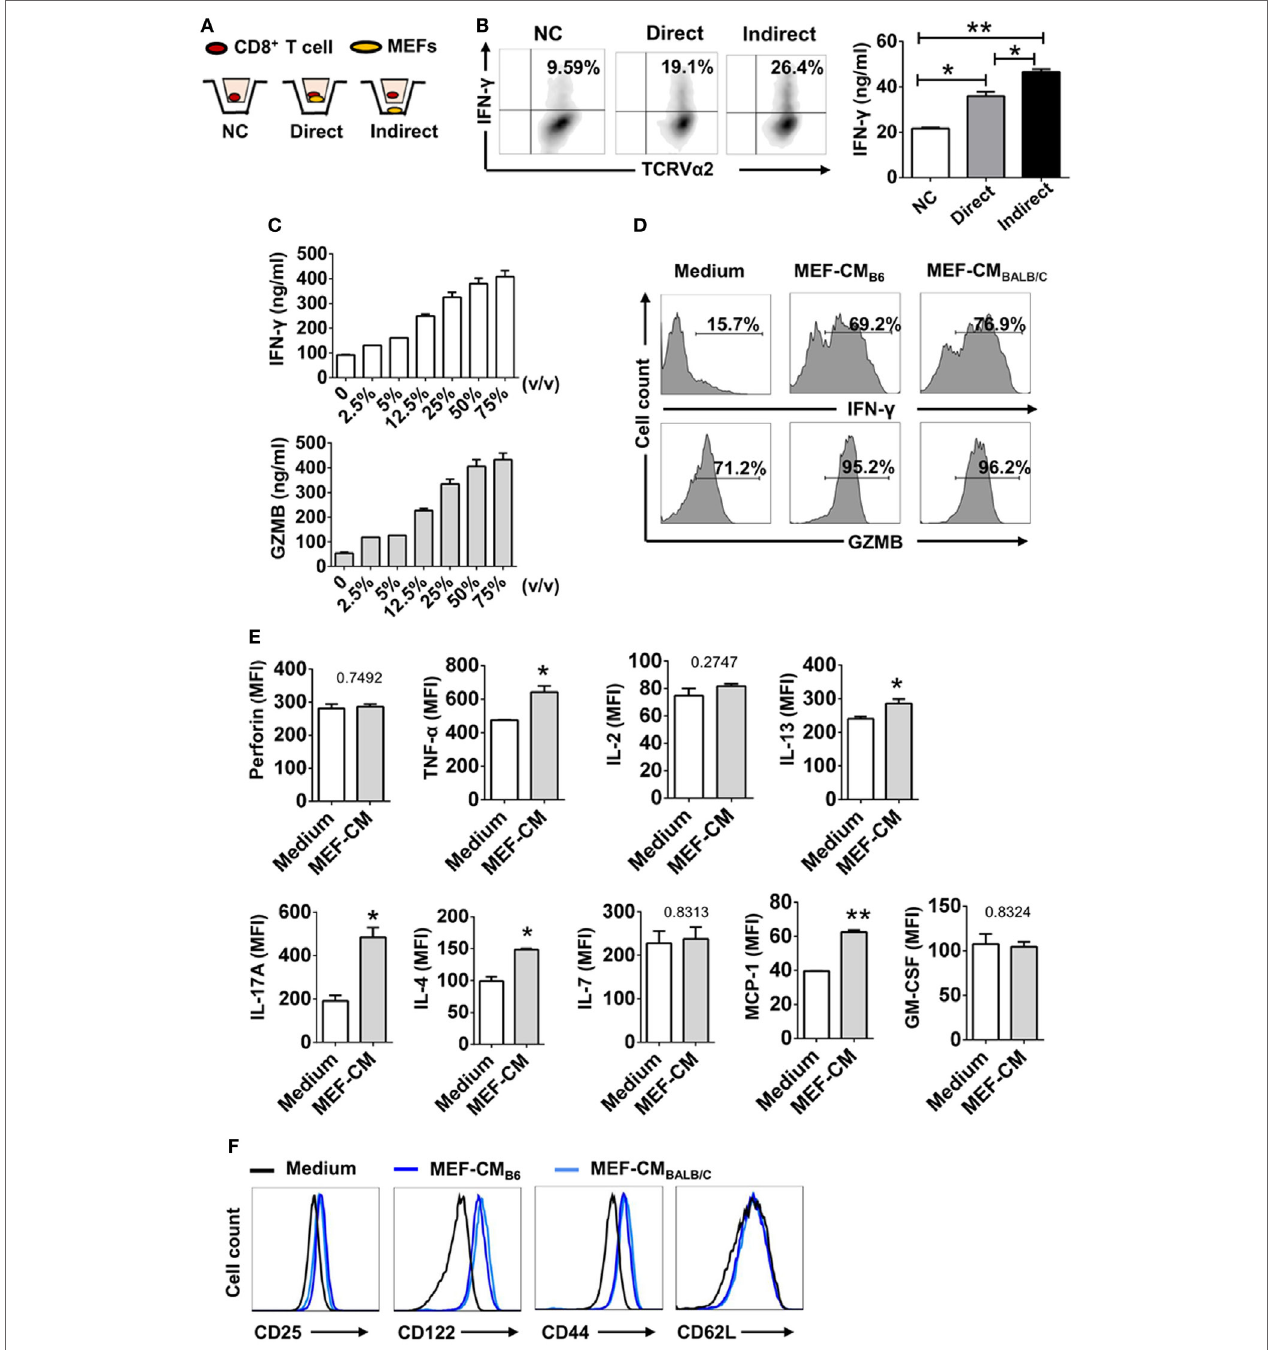
FigUre 2 | Mouse embryonic fibroblasts (MEFs) promote activation of CD8 + T cells through soluble factor(s). (a) Schematic diagram of trans-well co-culture system. (B) OT-1 CD8 + T cells (1 × 10 5 ) were incubated alone (No MEFs) or together with 2.5 × 10 5 B6 MEFs in the upper chamber (Direct), or CD8 + T cells in the upper chamber were incubated with 2.5 × 10 5 MEFs in the lower chamber (Indirect). After 3 days of TCR stimulation, interferon-gamma (IFN- γ ) production was evaluated by intracellular flow cytometry analysis. (c) OT-1 CD8 + T cells (1 × 10 5 ) were stimulated with different volumes of B6 mouse embryonic fibroblast- conditioned medium (MEF-CM) for 3 days. IFN- γ and granzyme B (GZMB) levels were quantified by ELISA. (D) OT-1 CD8 + T cells were stimulated in the presence (50%, v/v) or absence of B6 MEF-CM or BALB/c MEF-CM. 2 days later, the level of IFN- γ and GZMB was determined by flow cytometry analysis. Statistical significance was analyzed by one-way ANOVA with Bonferroni’s multiple comparison test (* P ≤ 0.05; ** P ≤ 0.01). (e) OT-1 CD8 + T cells were stimulated in the presence (50%, v/v) or absence of B6 MEF-CM for 2 days, the level of cytokines and chemokines was determined by flow cytometry analysis. Statistical significance was analyzed by unpaired t -test (* P ≤ 0.05; ** P ≤ 0.01). (F) Surface markers were analyzed following 3 days stimulation by flow cytometry analysis. All data represent three independent